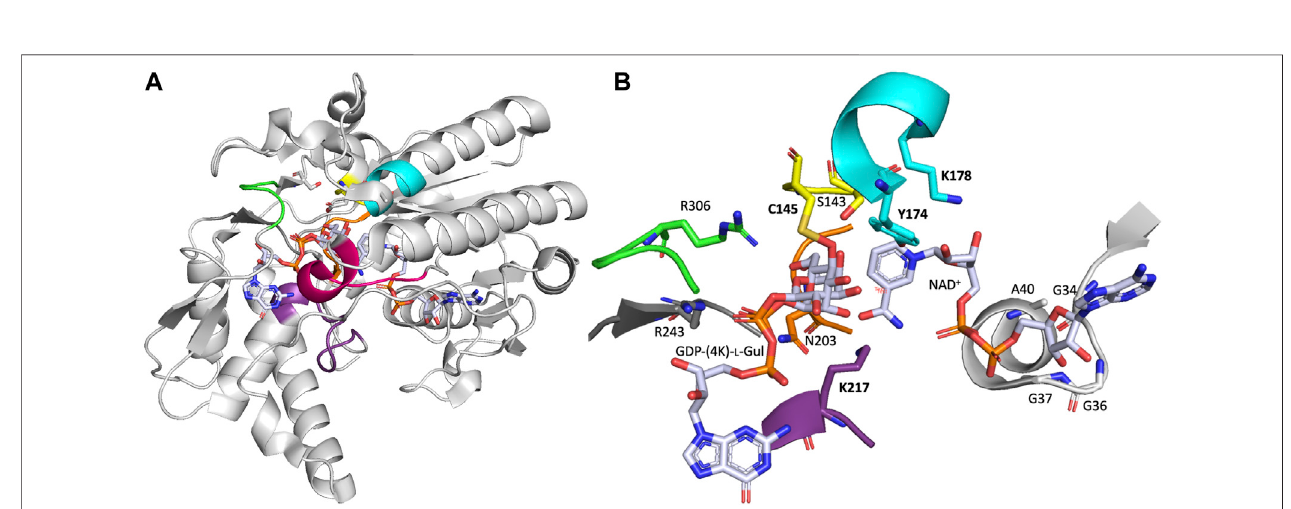
FIGURE2|(A) Onemonomerofthecrystalstructureof Arabidopsisthaliana GM35E( At GM35E,PDB:2C54)incomplexwithNAD + andthereactionproductGDP- L -Gul. (B) Zoomoftheactivesiteof At GM35EdepictedbyNAD + -bindingGlycine-richmotif(lightgrey)andthewallsoftheheptagonalboxmodel[inrespectivecolors,for details see (Da Costa et al., 2021) and Figure 3 ]. The “ Red wall ” is not shown as it would block the view on the sugar and nicotinamide moiety of the NDP-sugar and NAD + , respectively. The most important residues are shown in sticks. These include the conserved Ser, Tyr and Lys from the catalytic triad ([ST]x n Yx 3 K) for C4- oxidation/reduction (S143, Y174 & K178), the Cys-Lys catalytic acid/base couple (C145 & K217), the C143-acidifying Arg (R306), the Arg that make an important interaction with the substrate ’ s di-phosphate backbone (R243) and the highly conserved Asn in the orange wall